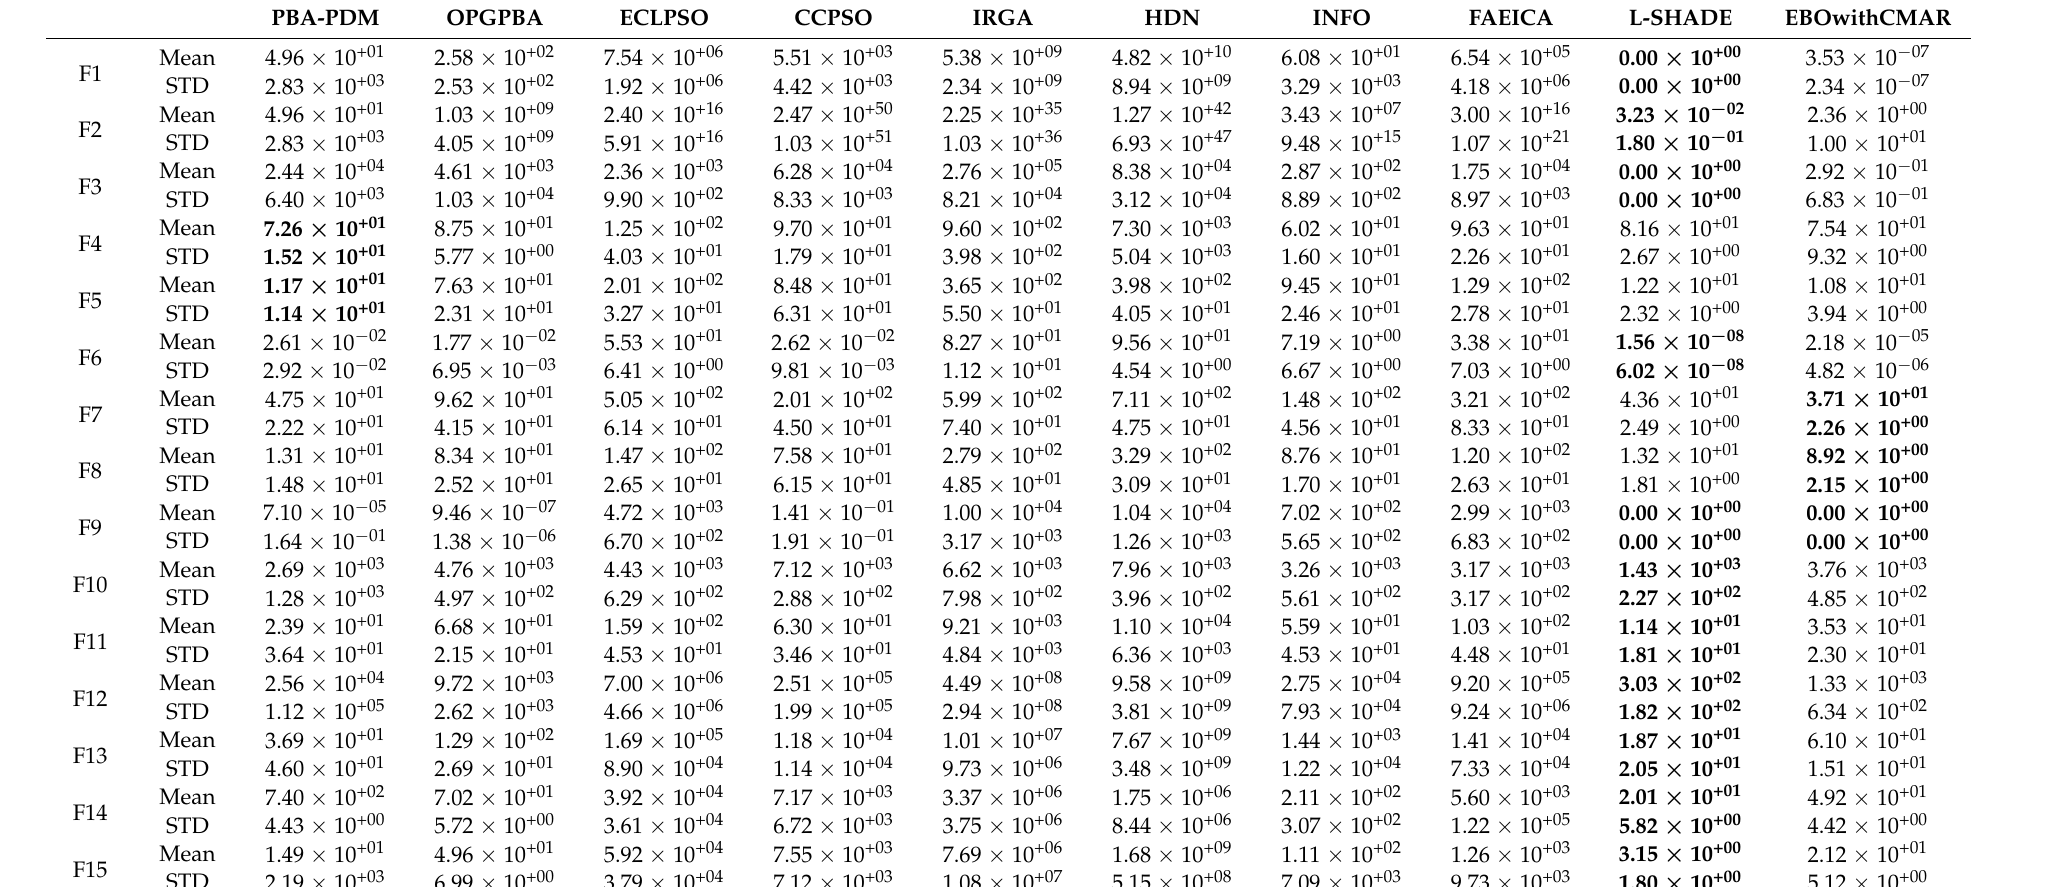
Table 8. Comparative results of the CEC2017 benchmark test functions in 30